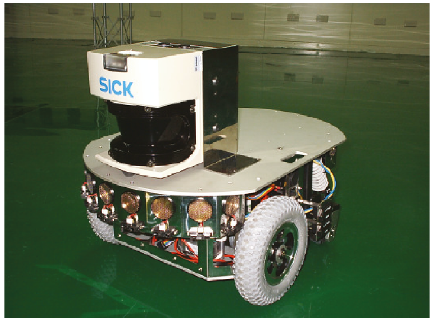
Figure 7: The mobile platform